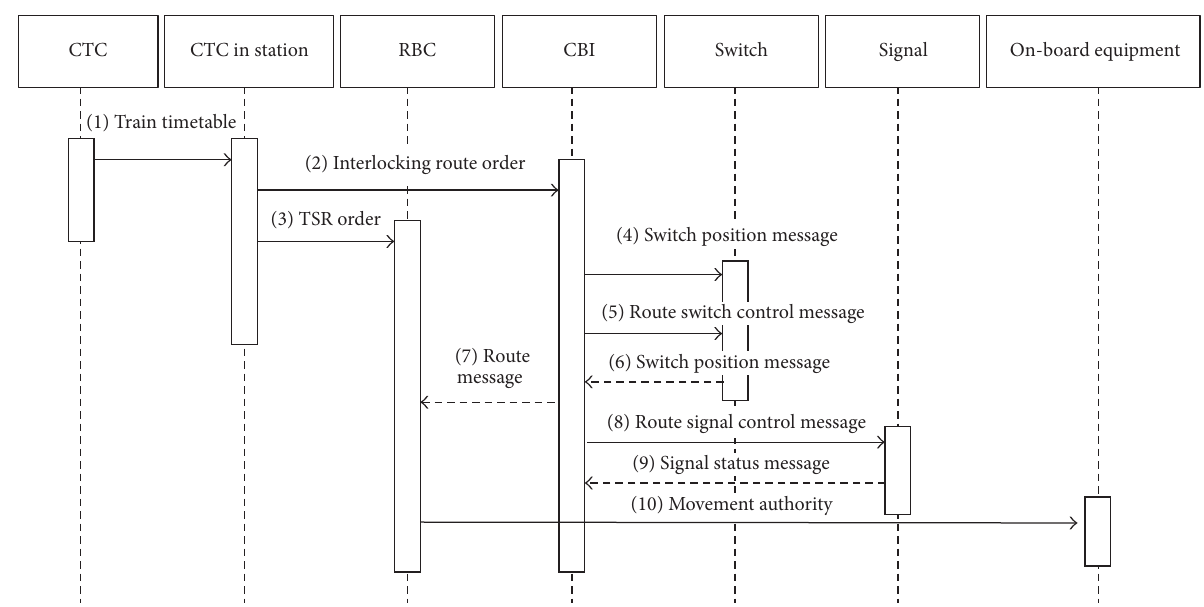
Figure 4: Sequence chart of information interaction for route building in